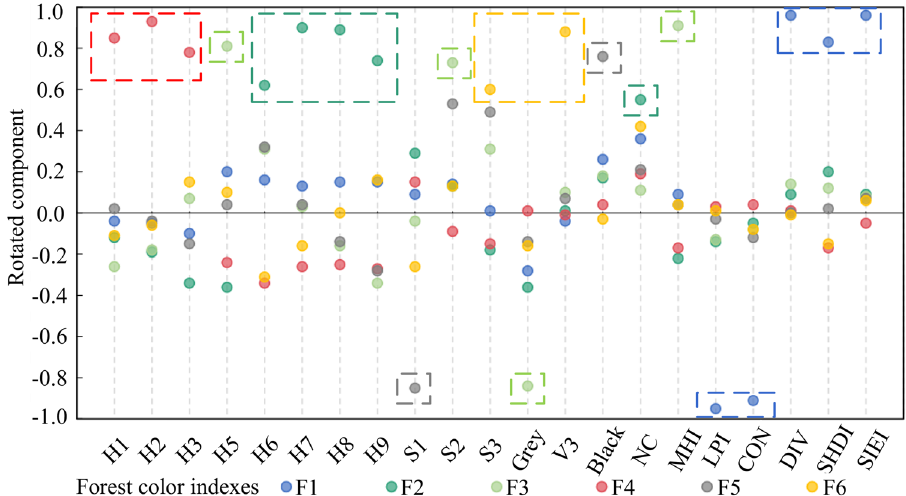
Figure 7. Rotated component matrix of the six common factors (F1–F6) produced using factor analysis of the 21 color indices that were significantly related to the scenic beauty estimation values. Each dashed box represents a common factor, and each holds those color indices that had significant correlations with that factor, as indicated by the factor color. See Fig. 6 for index